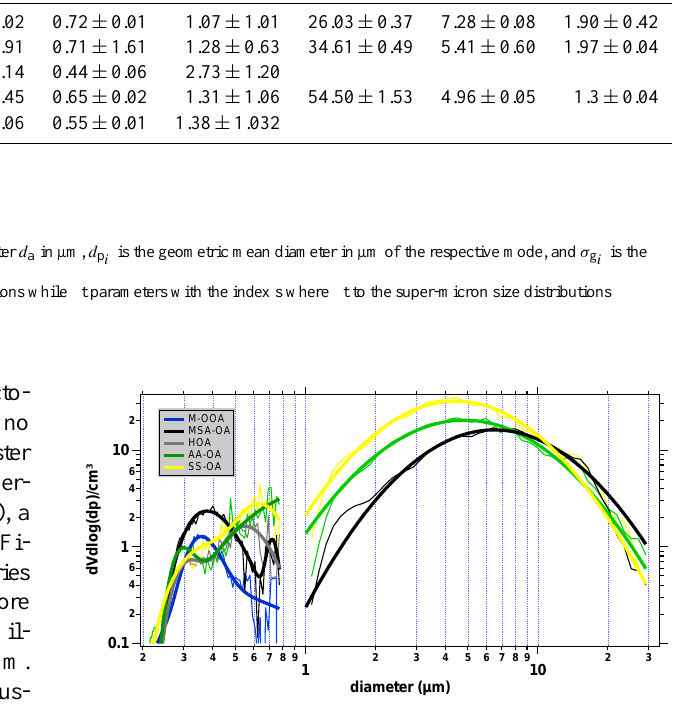
Table 5. Fit parameters of the log-normal volume size distributions for each PMF factor ∗ . Factor